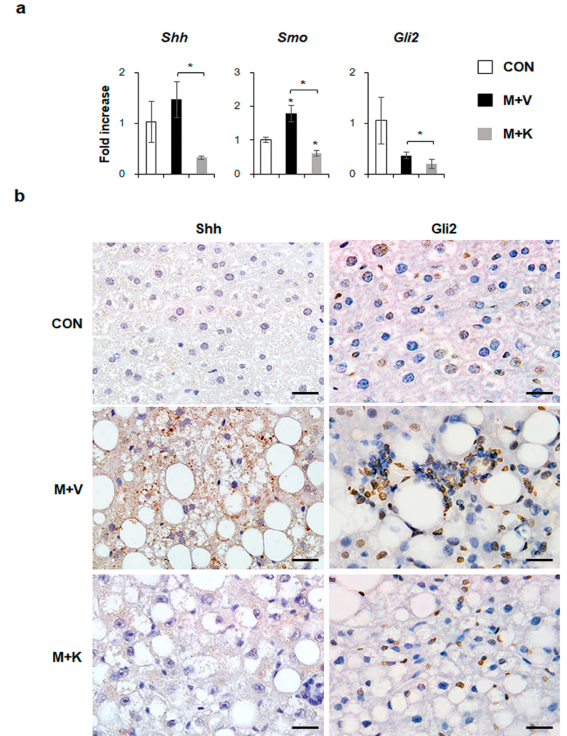
Figure 6. KT reduces expression of Hh pathway in db / db mice fed with MCD ( a ) qRT-PCR analysis for Sonic hedgehog (Shh), Smoothened (Smo), and GLI-Kruppel family zinc finger 2 (Gli2). Means ± SEM of results are graphed ( n ≥ 3 / group, * p < 0.05, ** p < 0.005 vs. control group). ( b ) Immunohistochemistry for Shh and Gli2 (brown color) in the liver sections from representative mice from each group (Scale bars: 20 µ